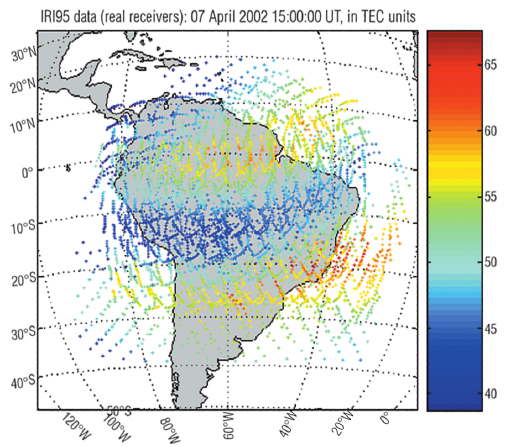
Fig. 2. Data coverage of the reconstruction region obtained by intersecting the ray paths with a shell at 400 km height. The colour code is associated with the slant TEC values.